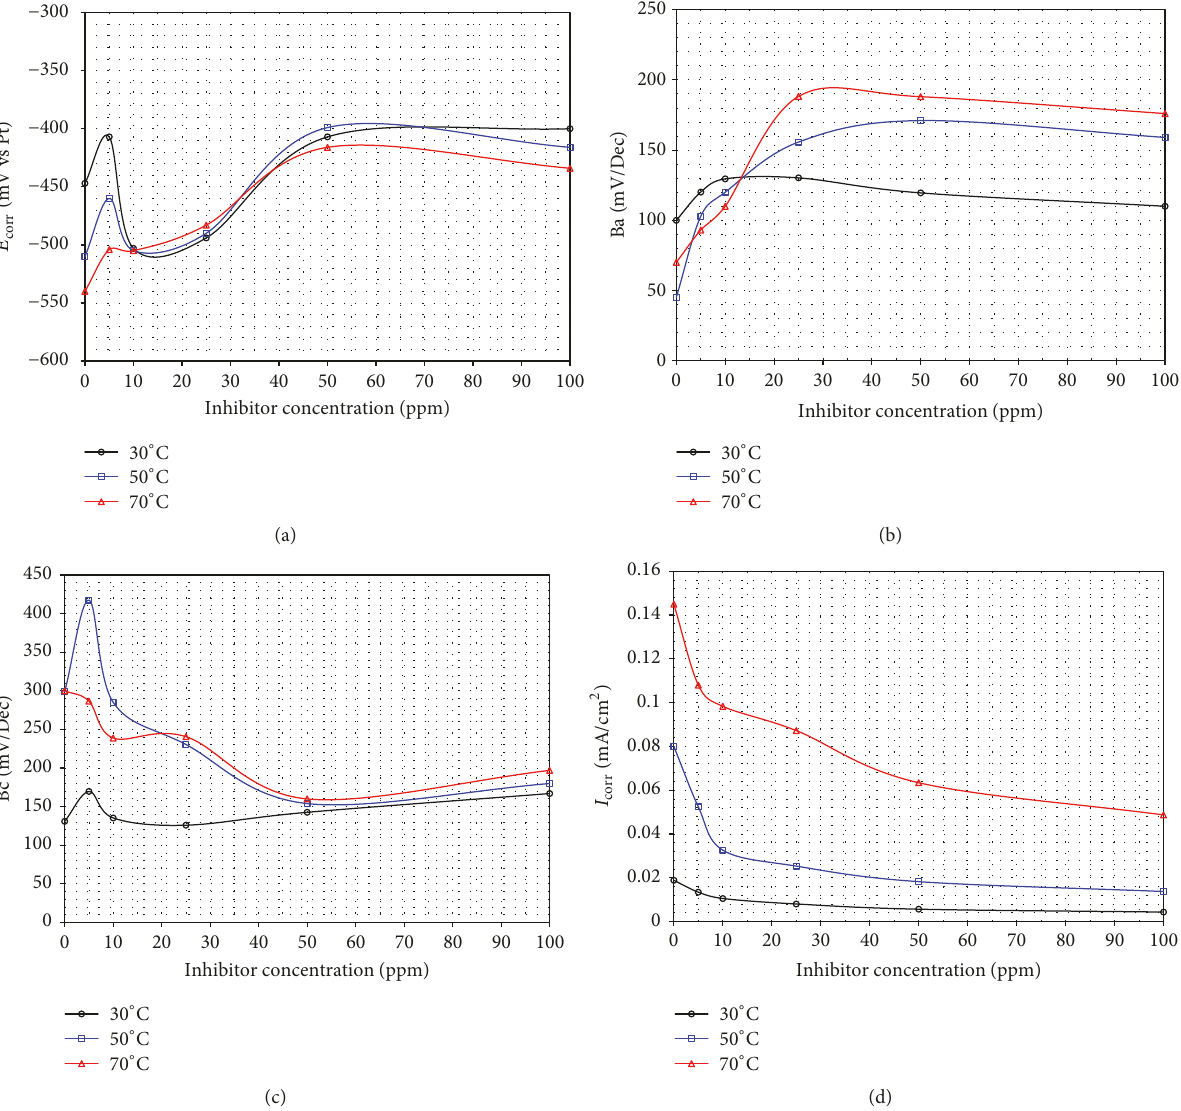
Figure 8: Electrochemical parameters for API X-70 steel in CO 2 -saturated saline solution as a function of inhibitor concentration and temperature: (a) corrosion potential, (b) anodic slope, (c) cathodic slope, and (d) corrosion current